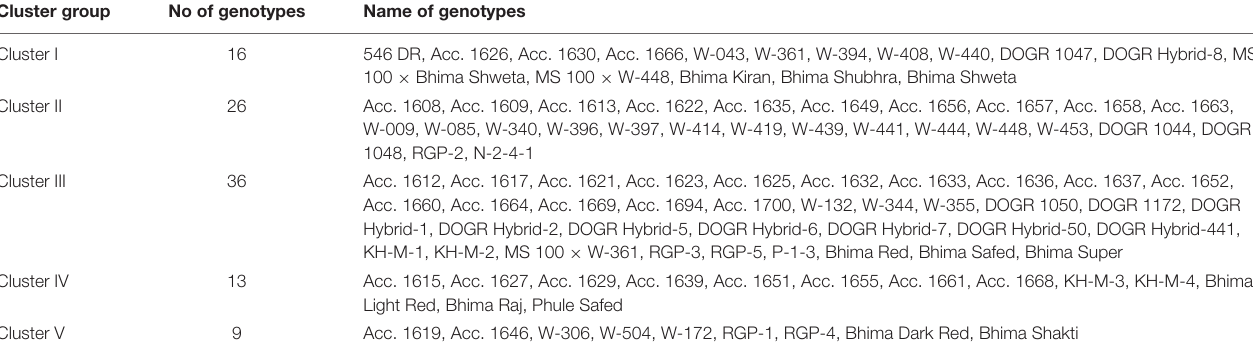
TABLE 9 | Grouping of 100 onion genotypes into six clusters based on Euclidean analysis. Cluster group No of genotypes